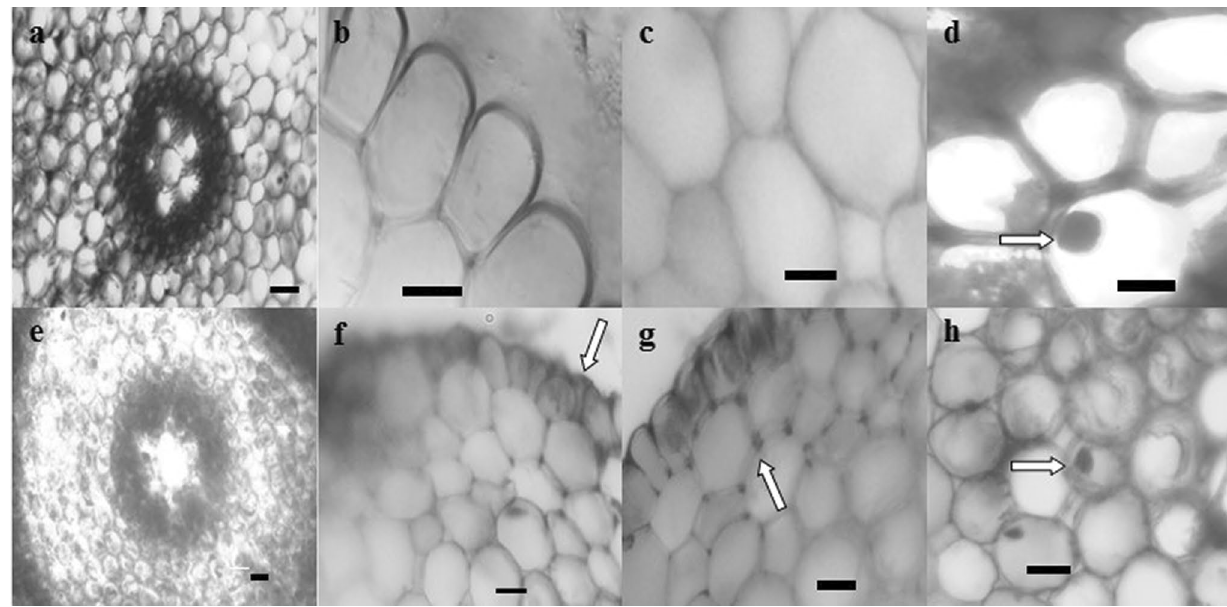
Figure 2. Meristematic cell damage. ( a ) Normal view of the transmission tissue, ( b ) normal appearance of epidermis cells, ( c ) normal view of cortex cells, ( d ) normal view of the cell nucleus, ( e ) indistinct transmission tissue, ( f ) epidermis cell deformation, ( g ) thickening of the cortex cell wall, ( h ) flattened cell nucleus) [Scale bar = 100 μm ( a , e ), Scale bar = 50 μm ( b )–( d ), ( f )–( h )].